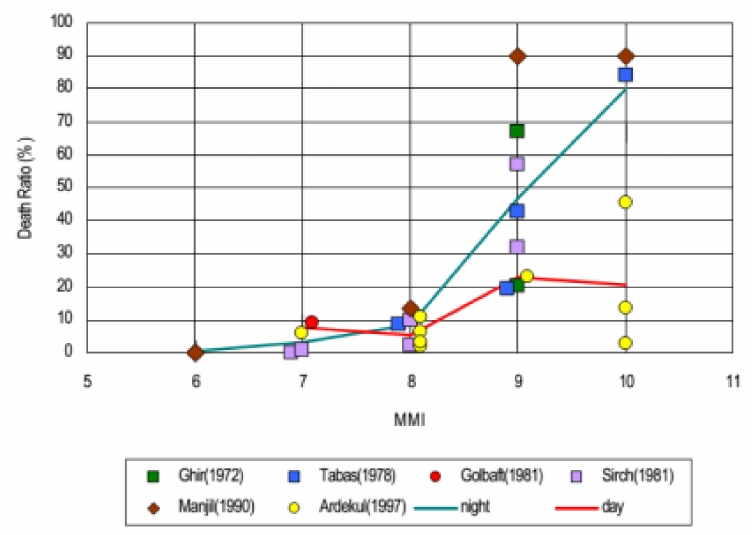
Figure 18. Observations of the casualty ratios in past earthquakes in Iran based on JICA studies